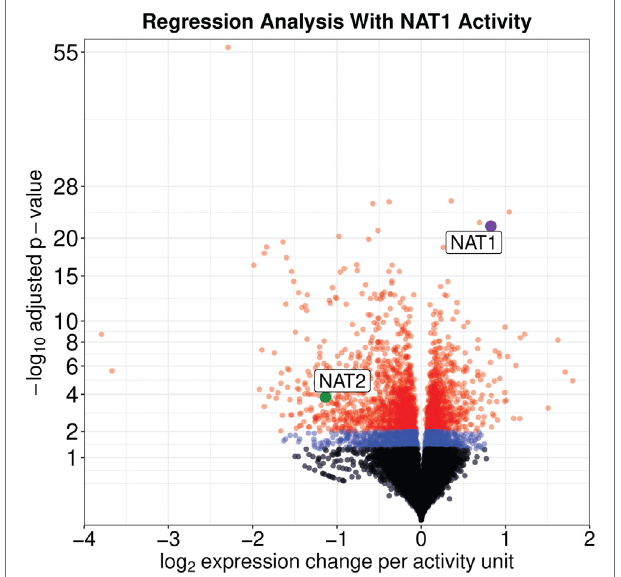
FIGURE 3 | Each cell line has a unique global transcriptome. Principal component analysis, a statistical method for reducing the dimensionality of a dataset to better understand total variance, was conducted for all samples. Eachsymbolrepresentsasinglebiologicalreplicate.Thisanalysisshows mostofthetotalvarianceinthedataset(52.2%)isbetweentheCRISPR-Cas9 generated cell lines from the other three cell lines. This analysis also shows each cell line has a distinct transcriptomic pro fi le but the biological replicates are very similar to each other.